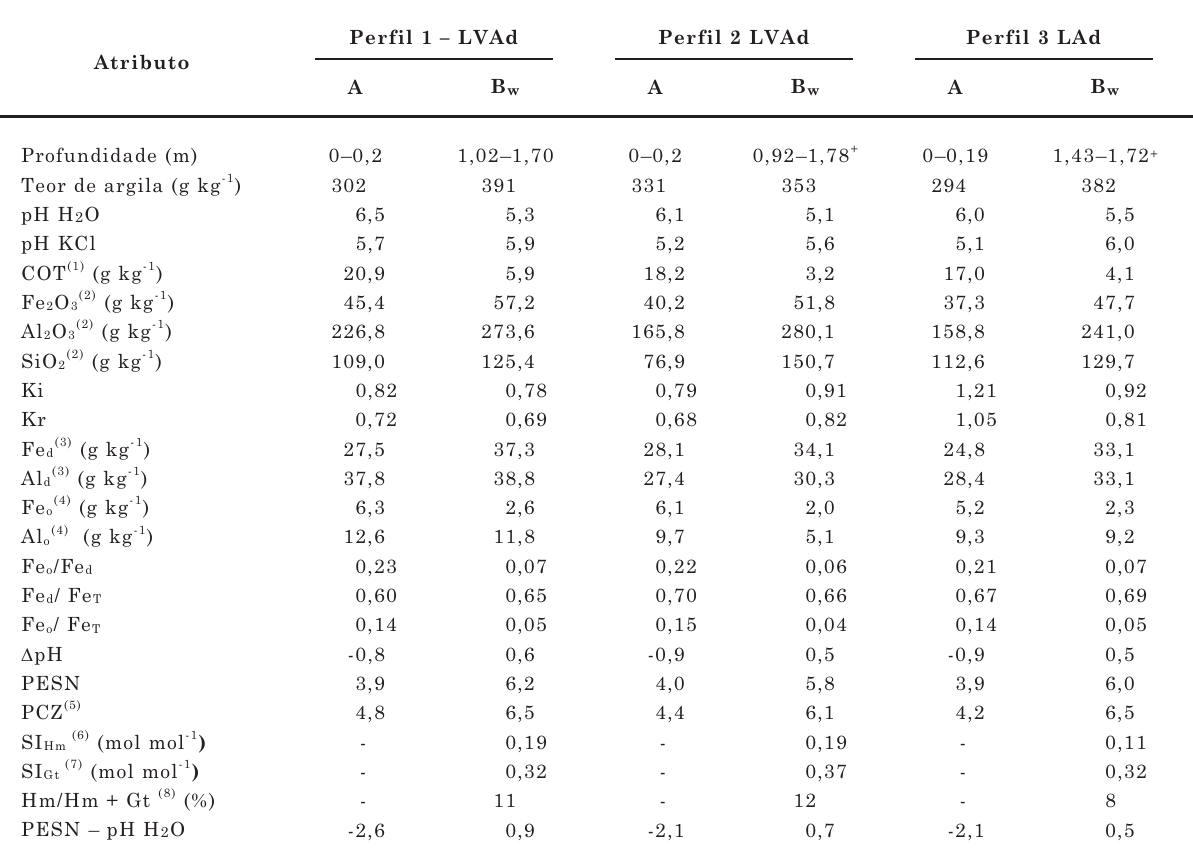
referente ao plano 110 da hematita (Schwertmann, 1988; Muggler et al., 2001). (7) Substituição isomórfica por Al na estrutura da goethita: Al (mol mol -1 ): 14,62–48,3. c = dimensão c da célula unitária da goetita, em nm, calculada a partir do Gt o valor obtido por DRX dos espaçamentos interplanares referentes aos planos 111 e 110 da goetita (Schwertmann & Carlson, 1994). (8) Hm/(Hm + Gt): 1/[A /(A . 0,708)] + 1 (Jones, Gt110 Hm104